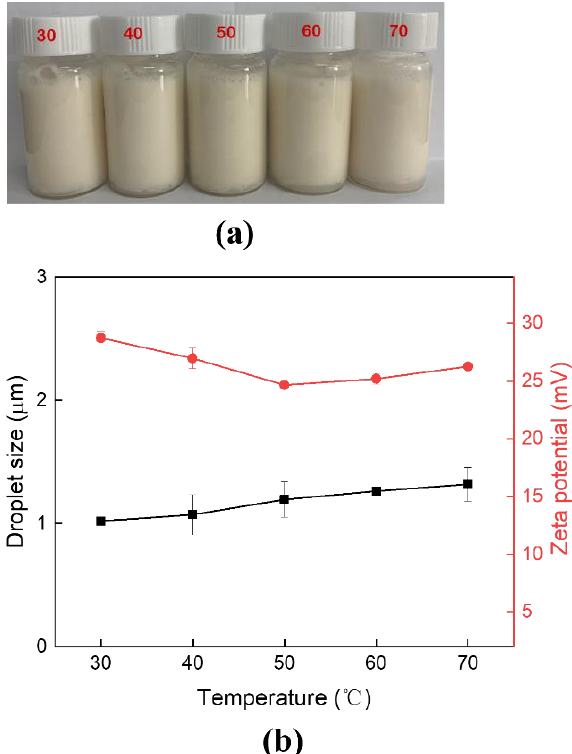
Figure 10. Effects of temperature on appearance ( a ) and droplet size ( b ) of Pickering emulsions stabilized by CS-PA-CD